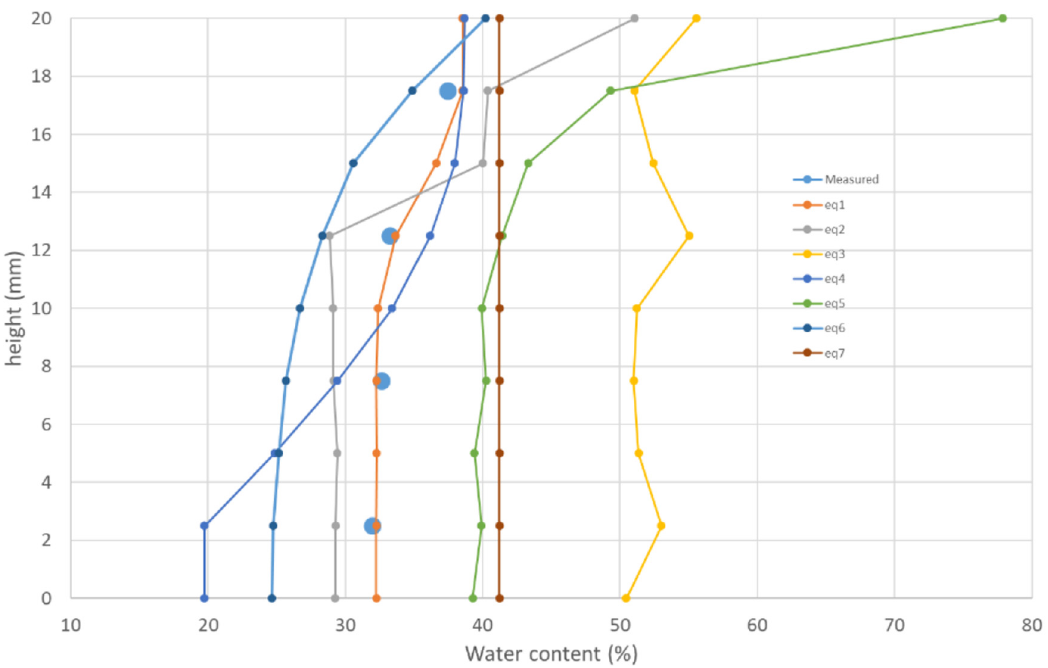
Fig. 9. Water content at the end of the test (cid:1) comparison between the experiment and the